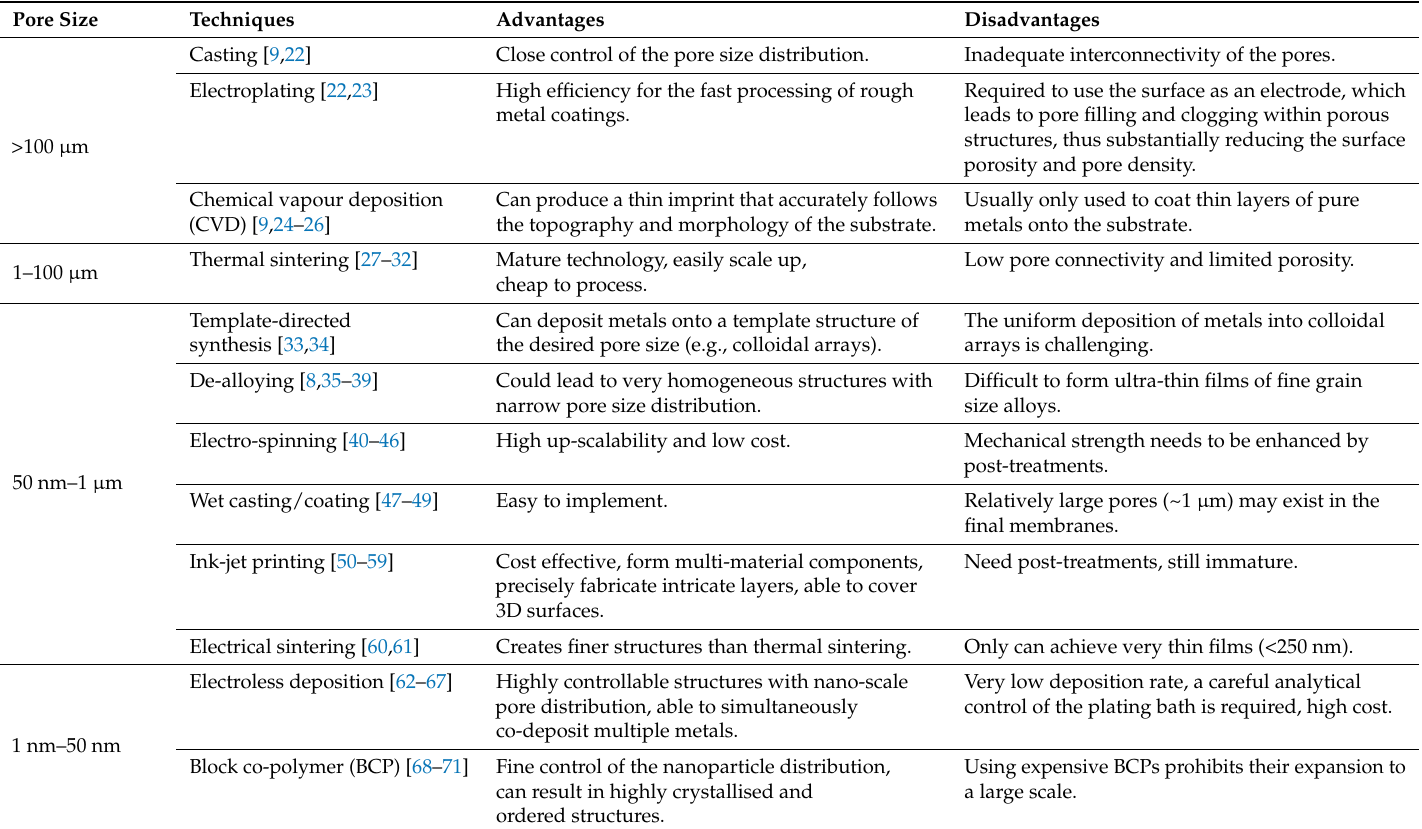
Table 1. Techniques used for the fabrication of porous metal frameworks with different pore size